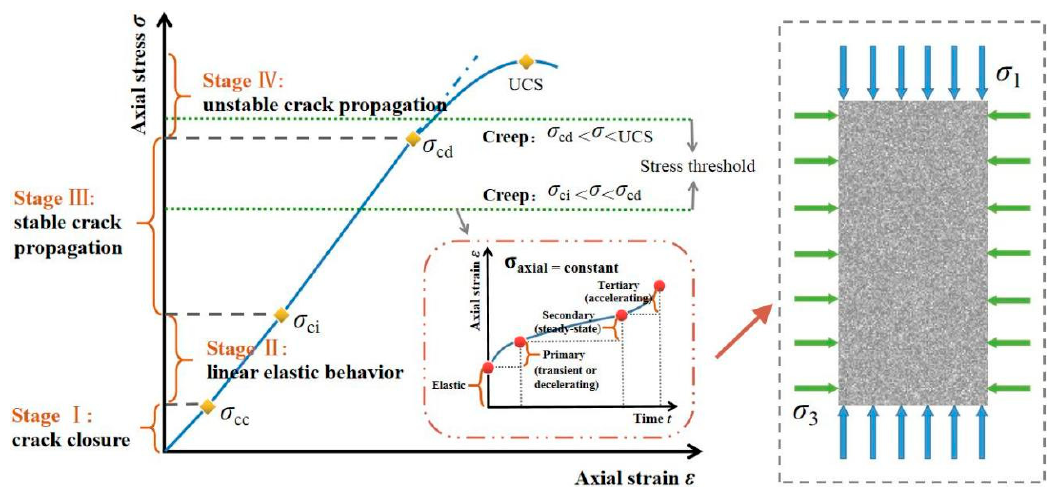
Figure 5. Stress–strain response and stages of rock during progressive fracture and classical creep behavior corresponding to the numerical model. Table 1. Rock material parameters of the numerical model.